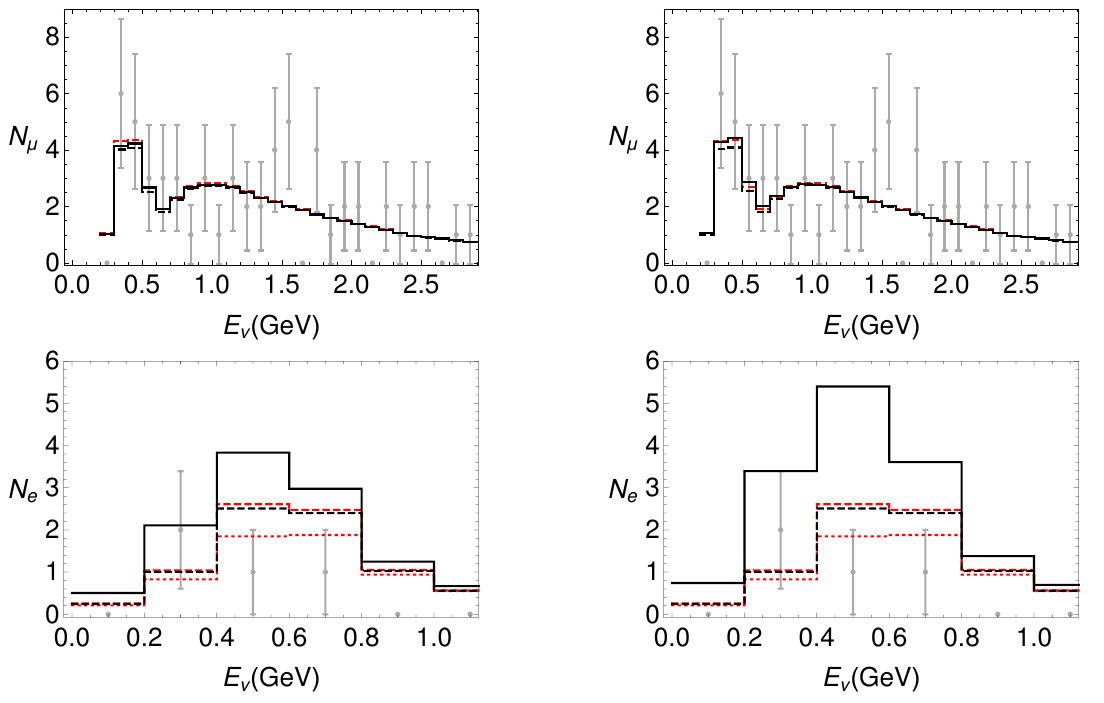
Figure 3 . As in (cid:12)gure 2, but for the antineutrino run, with T2K data from